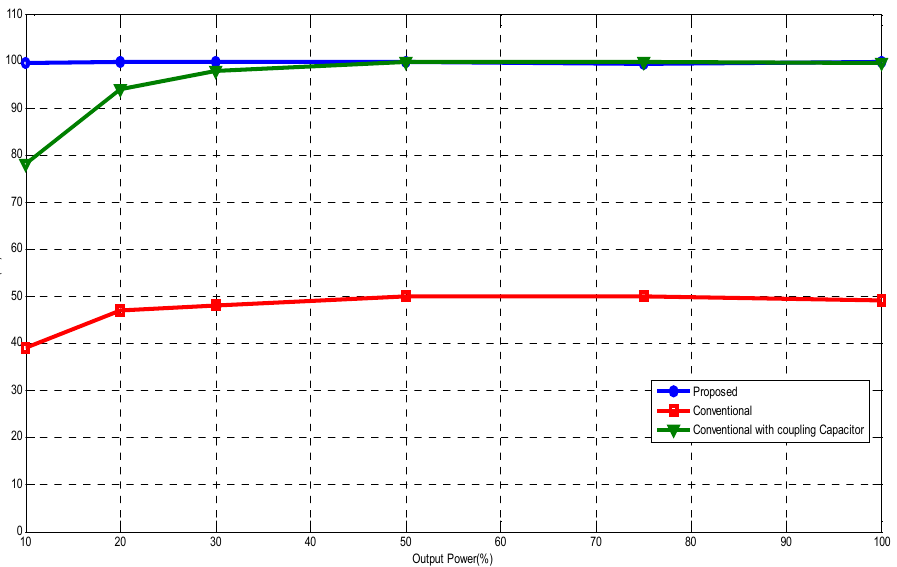
Figure 8. The variations of K u with output power of both conventional and proposed systems.